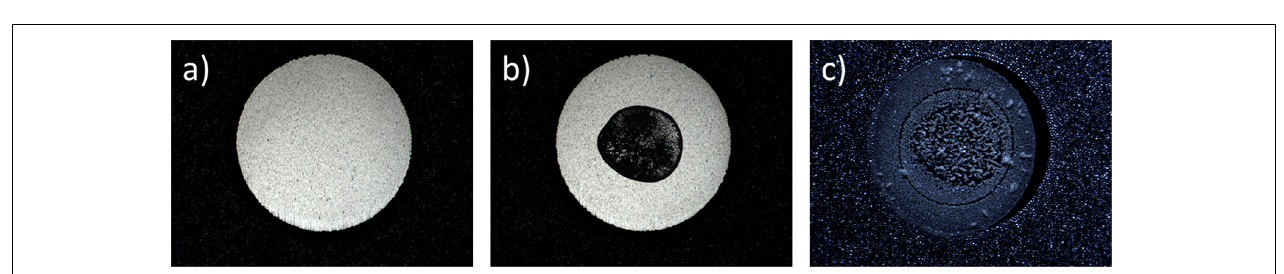
FIGURE 6 | Filter wand (FW) spotting step: (a) the FWs are applied on each MALDI-TOF MS spot (three contacts) with a controlled strength and Z level one by one after returning the vacuum level at atmospheric pressure. (b) Vitek R (cid:13) MS slide aspect at the end of spotting run.